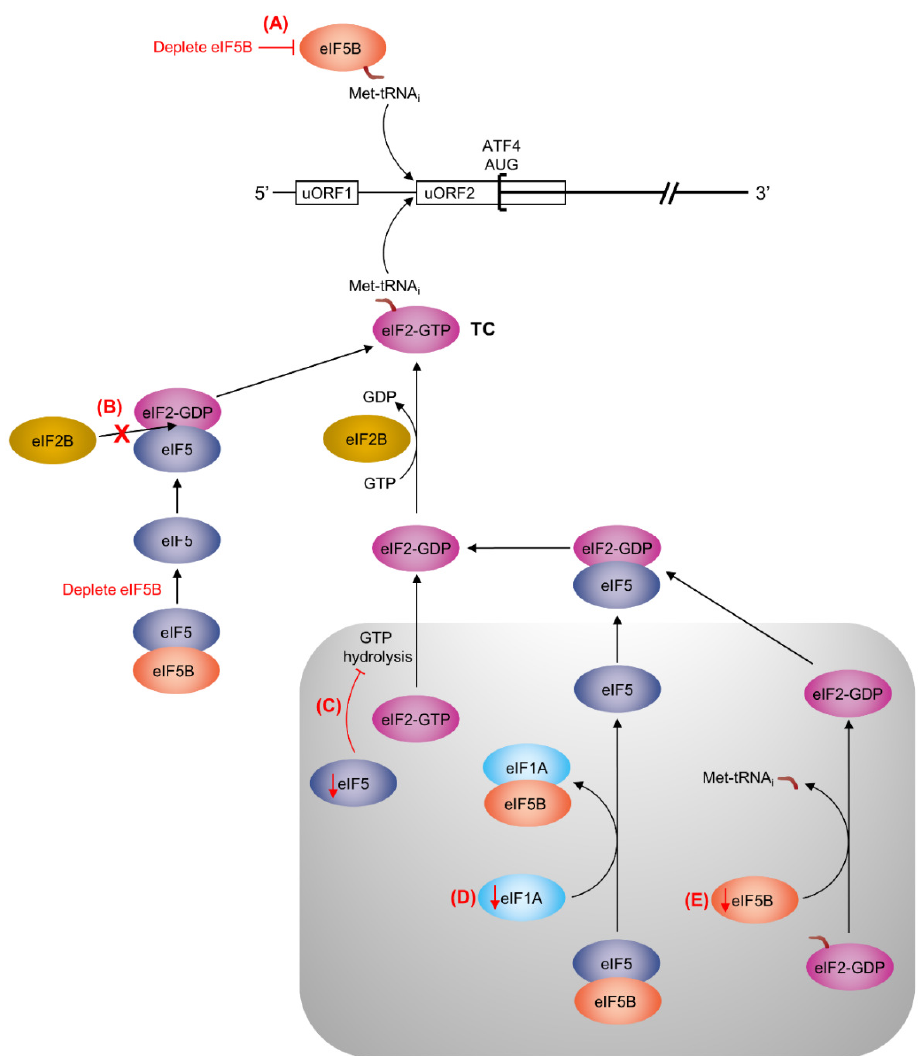
Figure 5. Possible mechanisms for uORF2-mediated repression of ATF4 translation by eIF5B, eIF1A, and eIF5. The ATF4 mRNA is represented as a horizontal black line, with uORF1 and uORF2 represented as rectangles and the ATF4 start codon represented as a square bracket. In the established mechanism of ATF4 repression, translation re-initiation will tend to occur at the uORF2 start codon when ternary complex (TC) is abundant; however, when TC abundance is decreased (e.g. by phosphorylation of eIF2α), re-initiation will be delayed, allowing the ribosome to bypass uORF2 and initiate translation of ATF4 [24]. Here, we propose several potential mechanisms ( A – E , highlighted in red), for uORF2-mediated repression of ATF4 by eIF5B (light orange), eIF5 (dark blue), and eIF1A (light blue). The pre-initiation complex (PIC) is represented by the grey box. Red arrows indicate a decrease of eIF5, eIF1A, or eIF5B. Note that this is not meant to be an exhaustive list and that any one (or any combination) of these mechanisms might be at play. ( A ) eIF5B might deliver Met-tRNA i to uORF2, providing an alternative to eIF2-GTP (pink). Depletion of eIF5B would consequently decrease translation initiation at the uORF2 start codon, increasing the translation of ATF4. ( B ) As eIF5B interacts with eIF5 [26], depletion of eIF5B could lead to an increase in free eIF5. Available eIF5 can form a complex with eIF2-GDP that can prevent the interaction of eIF2 with eIF2B (yellow), slowing TC re-formation [33,34]. ( C ) Depletion of eIF5 would inhibit GTP hydrolysis by eIF2 [33,35–37], preventing its release from the PIC and, subsequently, TC re-formation. ( D ) Depletion of eIF1A would prevent the displacement of eIF5B from eIF5 [26], inhibiting the release of eIF5 and eIF2 from the PIC and, thus, inhibiting TC re-formation. ( E ) Depletion of eIF5B would inhibit the displacement of eIF2-GDP from Met-tRNA i [33,35–37], thus inhibiting TC re-formation.